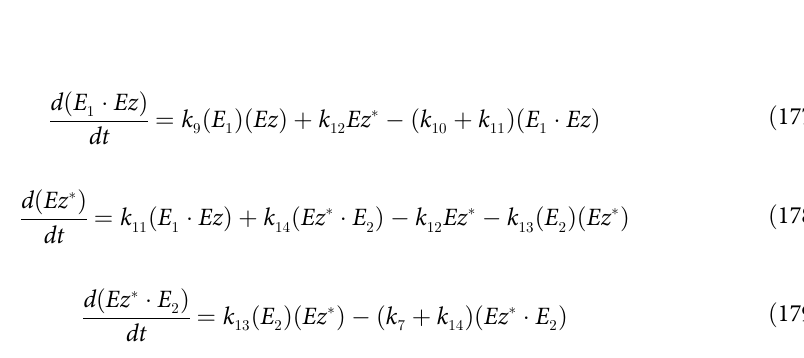
Minor differences between the m7 ping-pong and ternary-complex mechanisms. The dynamic behaviors of the ping pong-mechanisms are very similar to the (m7) ternary-complex mechanisms. Also here A is determined by the balancing of the three fluxes j set A ), the inflow described by k 6 , and the rate v = k 7 ( Ez � � E 2 ) making P . Accordingly, A described by Eq 160. Also, an increase of total enzyme concentration and an increase of the forward enzymatic rate constants k , k , . . . will improve the homeostatic performance of the 9 11 ping-pong controllers.